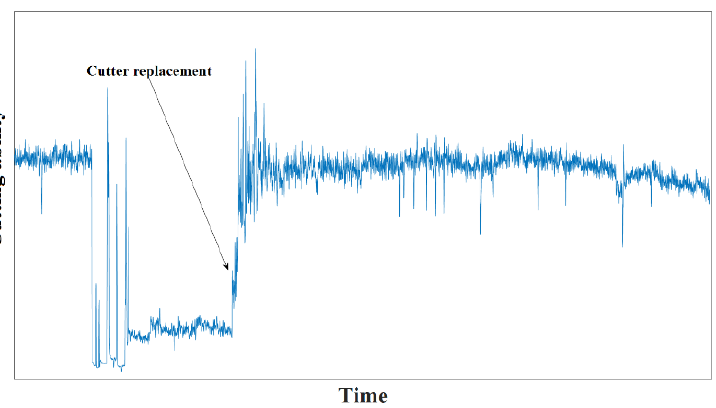
Figure 2. Cutting ability evaluation of the studied TBM before and after disc cutter replacements during 13 August 2015.